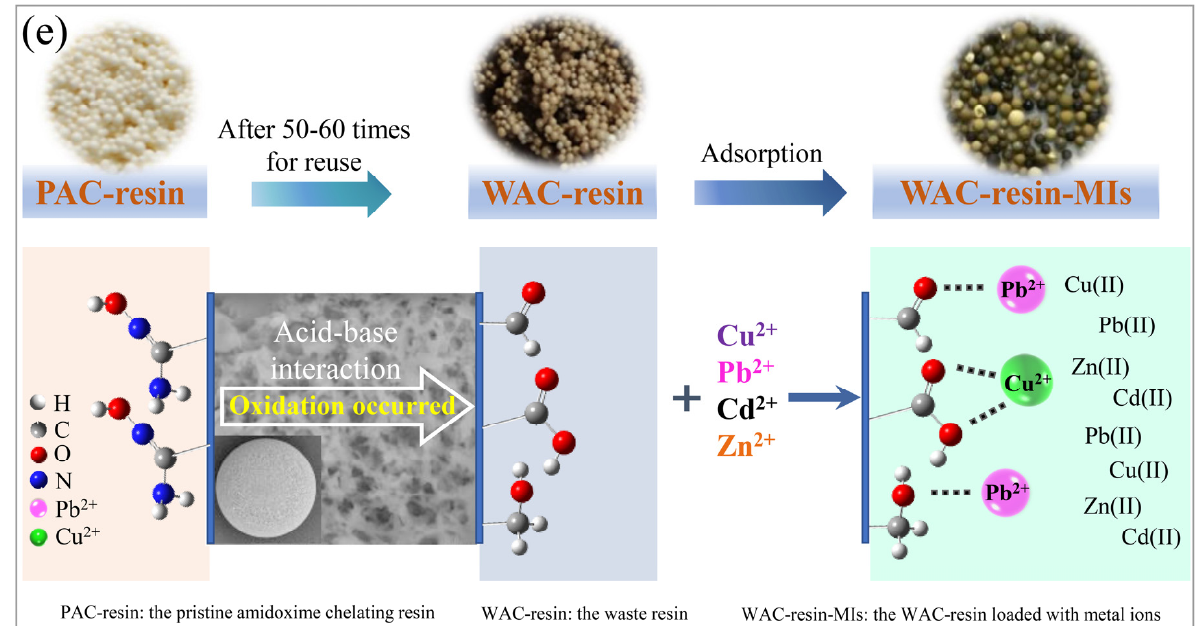
Figure 7. ( a ) XPS survey spectra and ( b ) FTIR spectra of the WAC-resin and WAC-resin-MIs; ( c ) the high-resolution XPS spectra of the O 1s region, ( d ) Pb 4f region and Cu 2p region; and ( e ) schematic diagram of the adsorption behavior of Pb(II) and Cu(II) onto the WAC-resin.